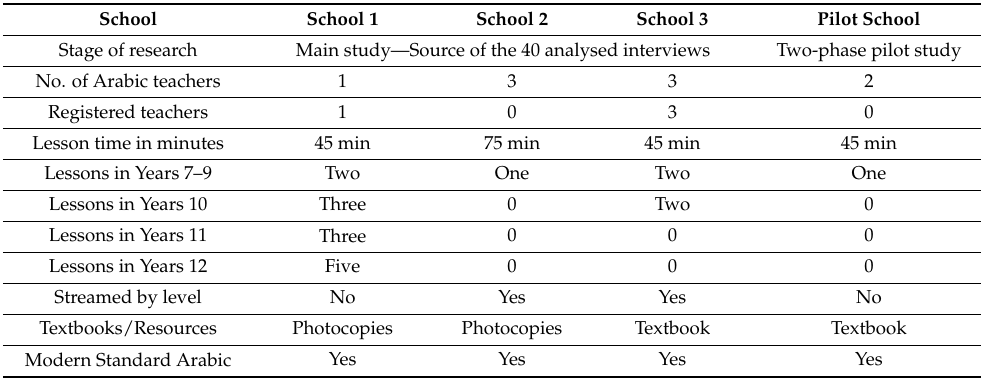
Table 1. The main research sites.